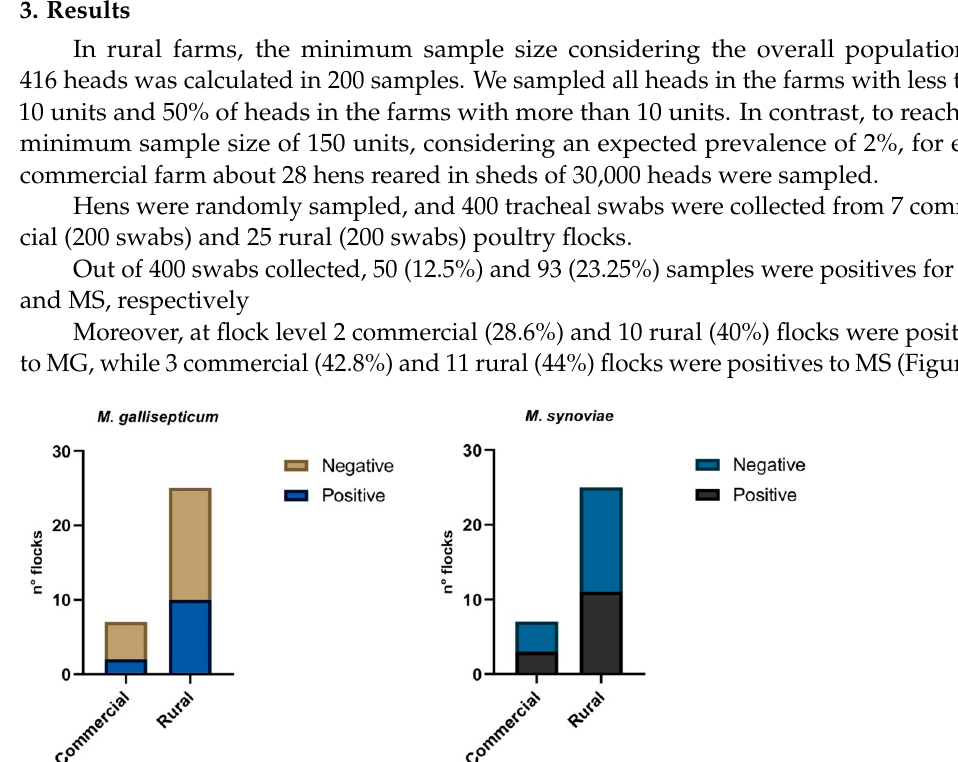
Table 1. Prevalence of MG and MG in rural flocks (* average prevalence). Flock